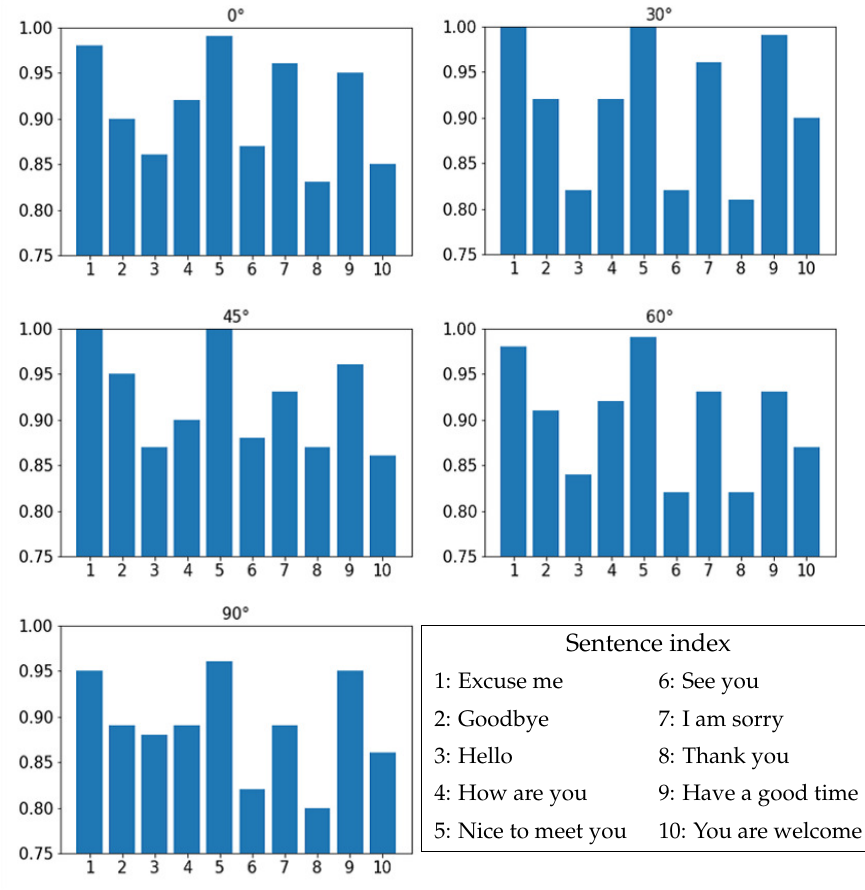
Figure 5. F1 scores in every class of our proposed multi-angle VSR model. The vertical axis indicates the F1 score, and the horizontal number means a sentence